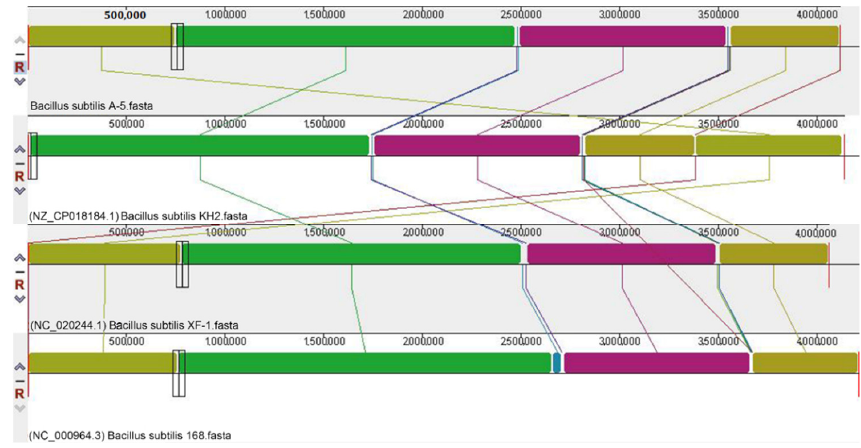
Figure 8. Synteny analysis of B. subtilis A-5, 168, KH2, and XF-1 by Mauve.